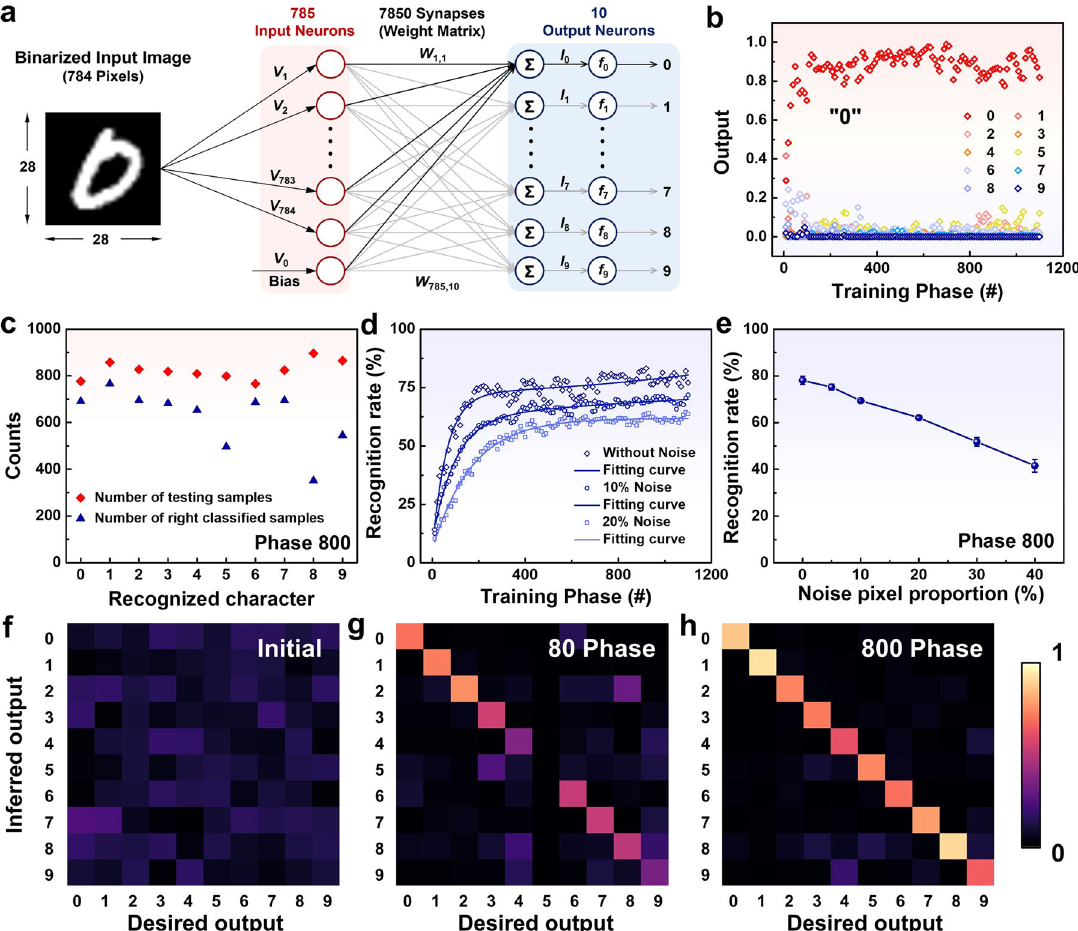
Fig. 5 A demonstration of pattern recognition simulation. a Schematic of the SLP-based ANN consisting of 785 input neurons and 10 output neurons. b Output signals of 10 numbers as a function of training phase. The number ‘ 0 ’ can be recognized from other numbers because of the maximum output. c Recognition accuracy of 10 numbers from ‘ 0 ’ to ‘ 9 ’ at the 800th phase. d Recognition rate as the function of training phase under different noise pixel proportion (0, 10%, and 20%). e Recognition rate as the function of noise pixel proportion (0 − 40%). Error bars represent standard errors investigated by three times independent pattern recognition processes. f Confusion matrix of recognition results before training. Confusion matrices of recognition results at g the 80th phase and h the 800th phase. When a large value appears on the diagonal line, the corresponding number can be successfully identi fi